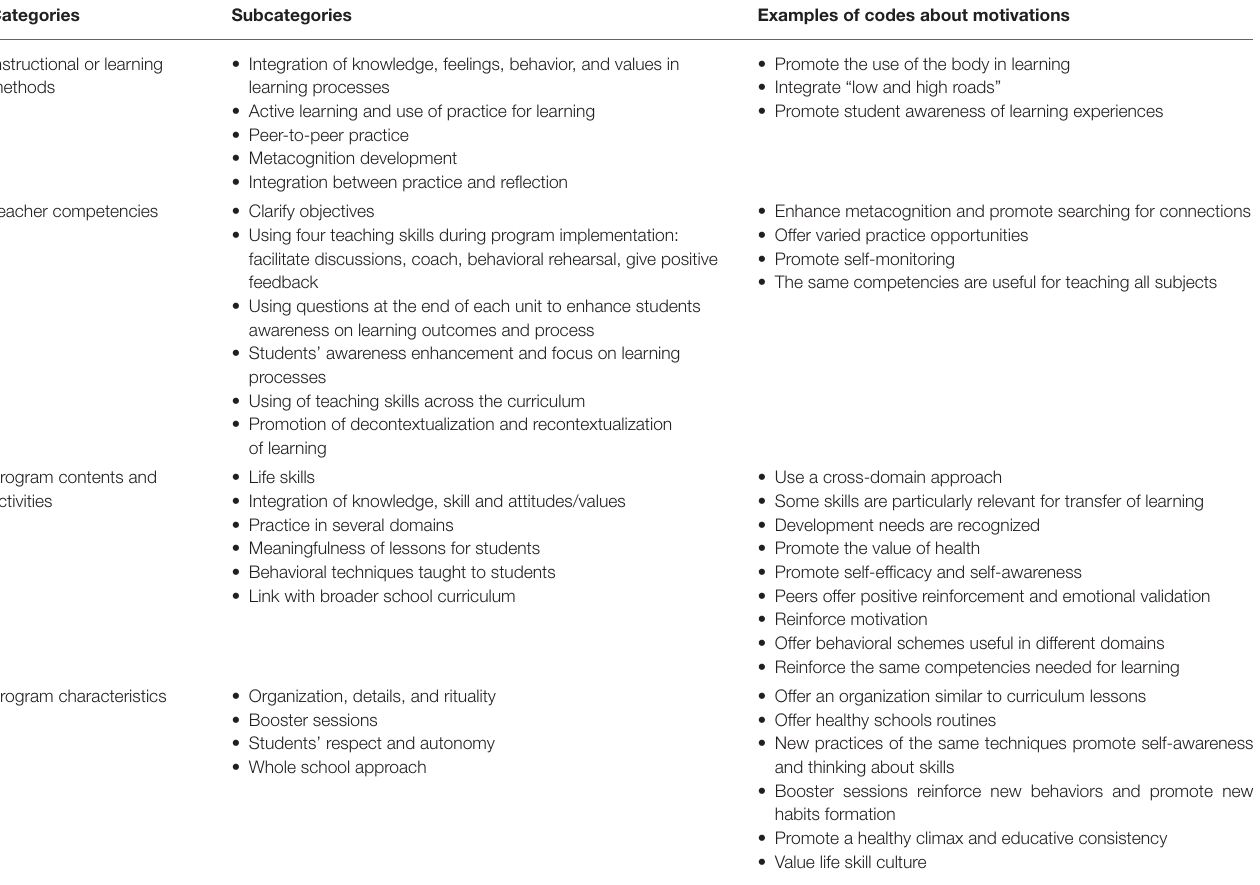
TABLE 2 | Conditions or characteristics of the LST program that can facilitate the transfer of learning to different health behaviors.